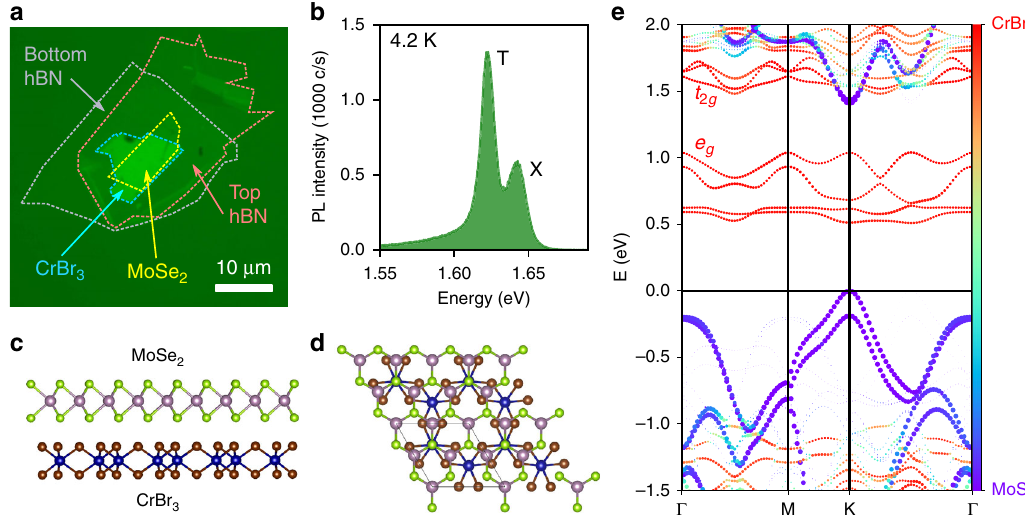
Fig. 1 MoSe 2 /CrBr 3 van der Waals heterostructures. a Microscope image of the sample in this work showing multi-layered CrBr 3 , monolayer MoSe 2 , and hBN encapsulation layers. b Photoluminescence spectrum from the sample under continuous-wave laser excitation at 1.946 eV and a sample temperature of 4.2 K. Neutral exciton (X) and trion (T) peaks are visible. c, d Schematics of a MoSe 2 /CrBr 3 heterobilayer structure used in the density functional theory calculations, viewed from the side (c) and top (d), where the supercell is highlighted. Here, the experimental lattice constant of monolayer MoSe 2 is applied to both layers, in order to simplify the calculations, along with setting the relative crystallographic twist angle to zero between the layers (see Supplementary Note 1). Crystal images were produced using VESTA software 33 . e The DFT calculated electronic band structure of the MoSe 2 /CrBr 3 heterobilayer, projected on the host material. The global valence band maximum is localized in MoSe 2 at E = 0. The green band color indicates hybridization between the two materials. The e g -orbitals have spin polarization opposite to the t 2 g